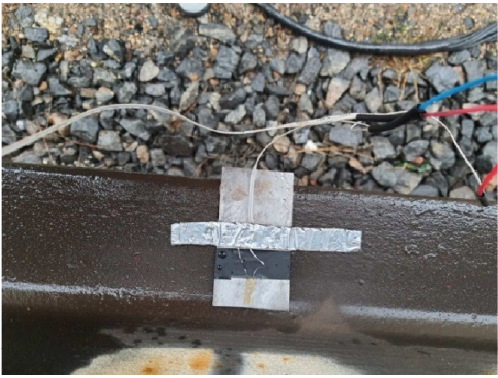
Figure 7. Compensating strain gauge on the plate.